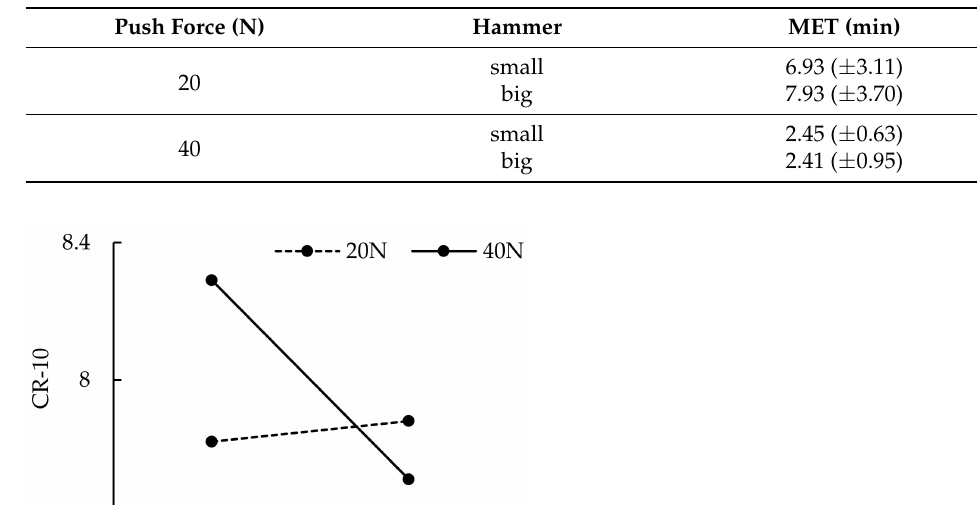
Table 1. MET values under experimental conditions.